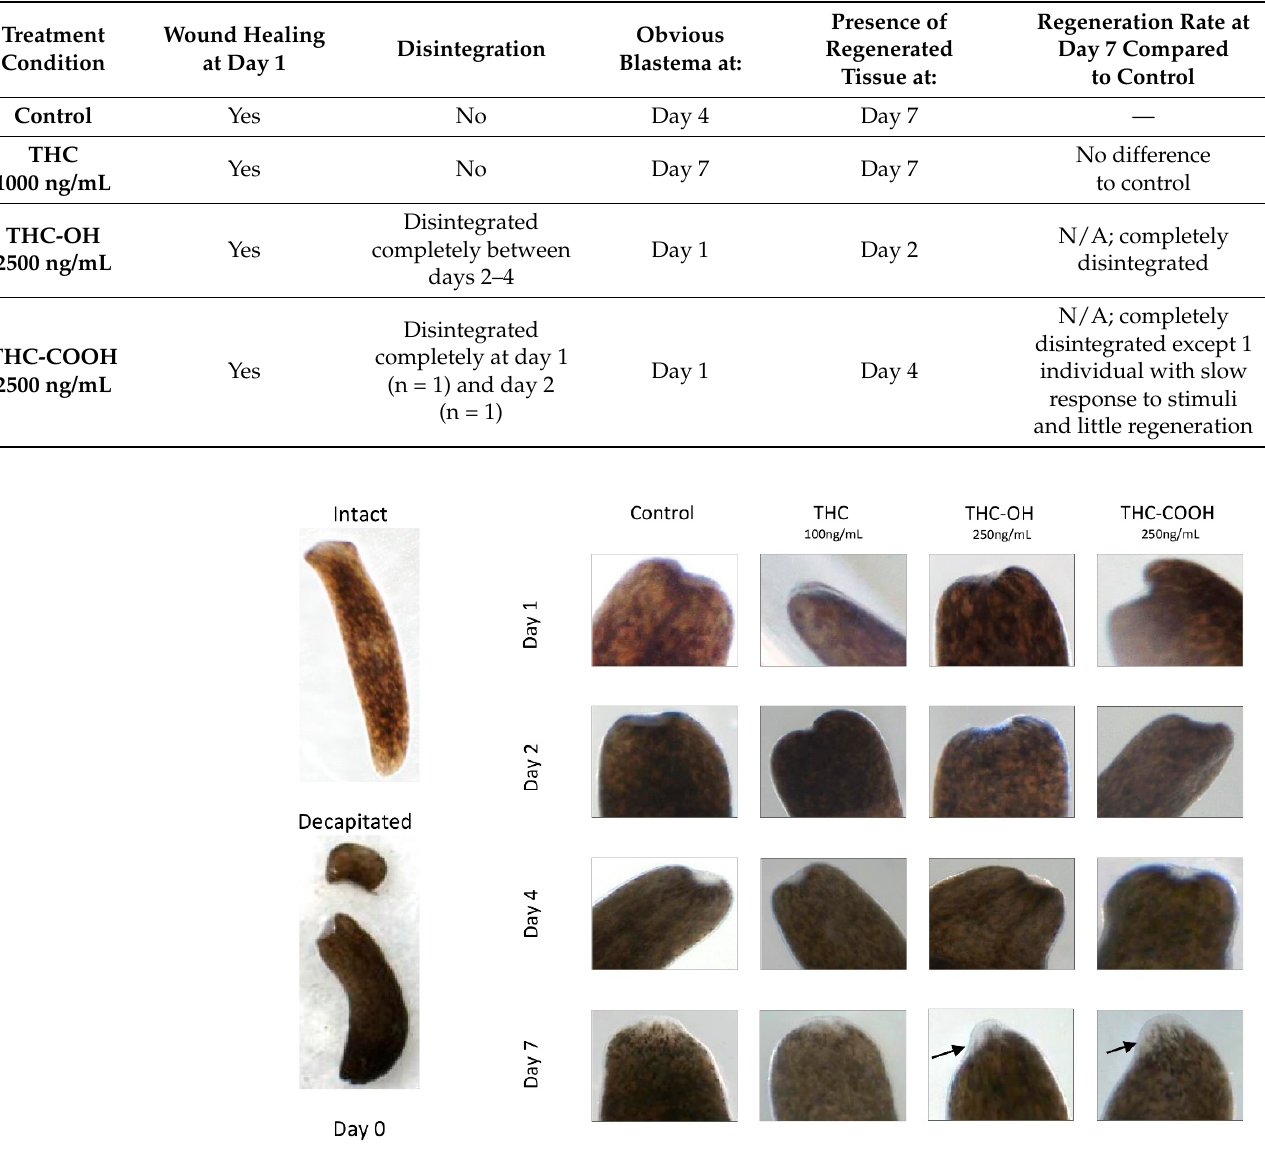
Table 3. Detailed data for the effect of high concentration treated planaria for a week.